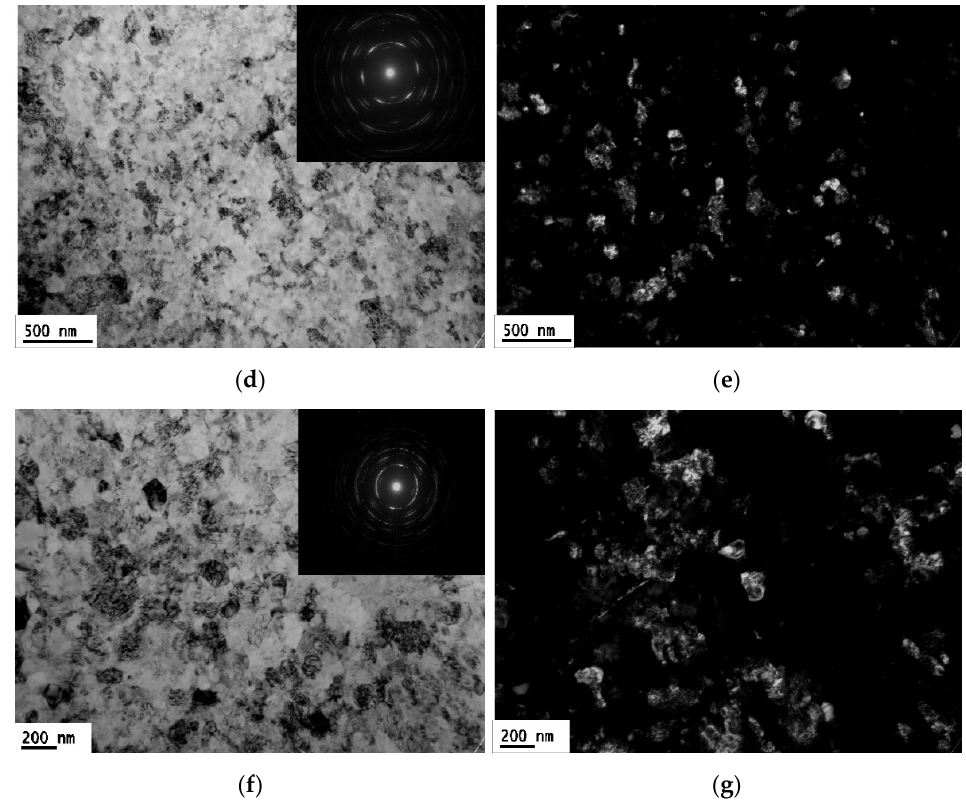
Figure 3. Microstructures of CP-Ti in ( a ) as-annealed state (OM image, magnification 100×), and after HPT processing to ( b ) 1 turn in disc centre area (OM image, magnification 100×), ( c ) 1 turn in disc edge area (OM image, magnification 200×), ( d , e ) 10 turns ~4 mm from disc edge area (TEM bright field and dark field images), ( f , g ) 20 turns ~4 mm from disc edge area (TEM bright field and dark field images).